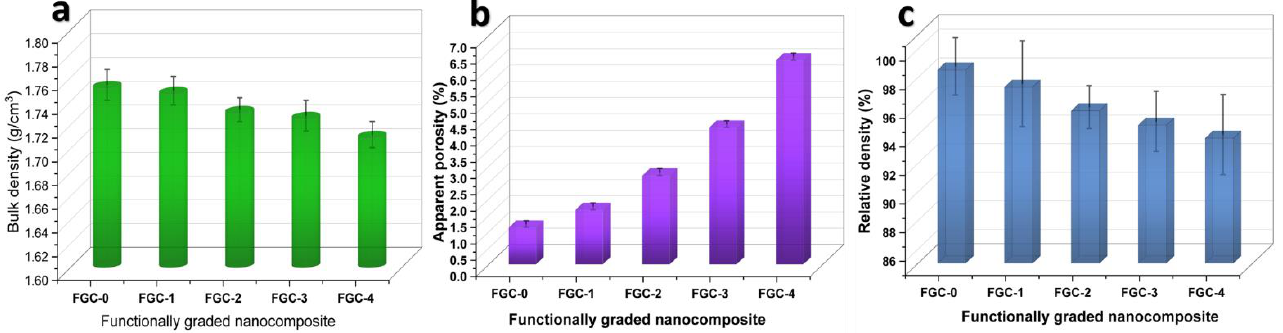
Figure 9. ( a ) Bulk density, ( b ) apparent porosity, and ( c ) relative density of FGCs sintered at 560 °C for 1 h in